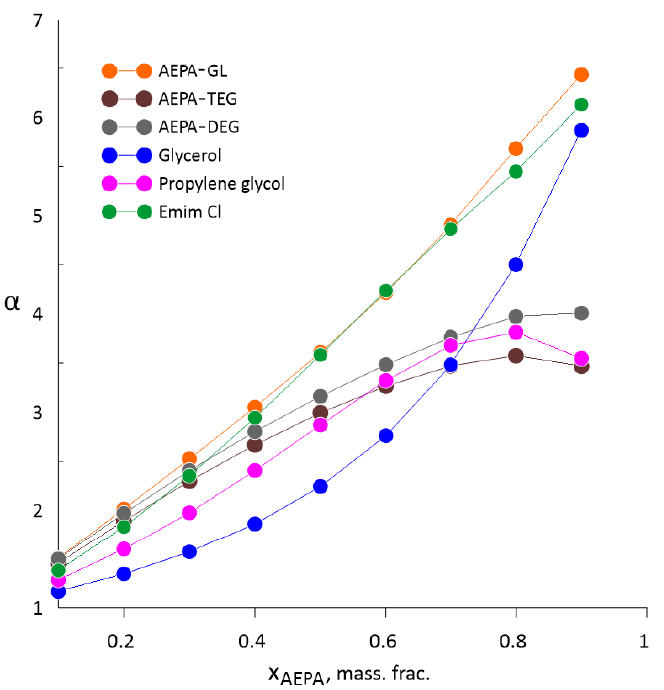
Figure 7. The coefficients of the relative volatility depending on the concentration of the extractant at the azeotropic point of the ethanol–water mixture (ethanol: 95.6 wt.%).